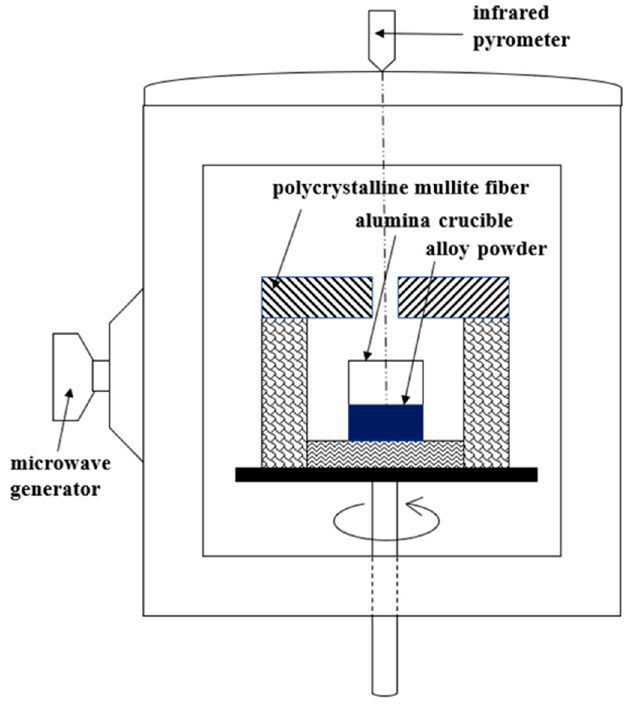
Figure 1. Schematic illustration of microwave-sintering apparatus.